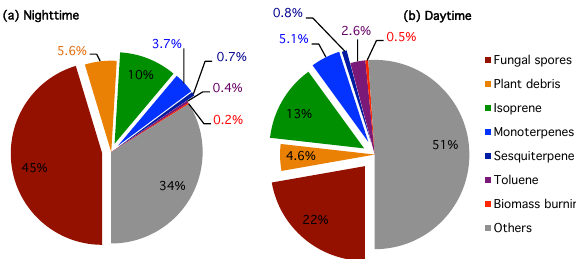
Figure 4. Contributions from different sources to organic carbon in the Wakayama forest aerosols during the nighttime and the